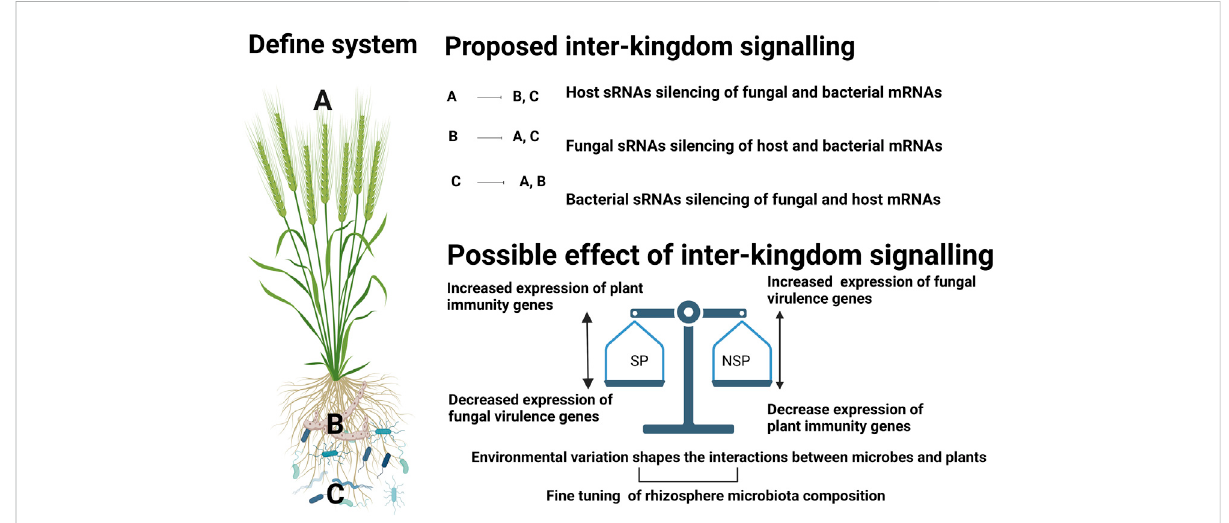
FIGURE 2 Schematic for possible ways of sRNA mediated gene regulation in wheat-rhizoctonia-microbiome interactions and possible effect of such interactions in the context of disease suppressive soils. We proposed involvement of sRNAs from three components: i) plant host, ii). fungal pathogen, iii). bacterial community, with possible multidirectional interactions. During thecomplex interaction of plant association with rhizosphere community, Inter-kingdom signalling might happen in such a way that plant sRNAs (A) could be taken up by fungal (B) (Cai et al., 2018) and bacterial (C) cells thereby mediating regulation of their genes (Teng et al., 2018). In the second case, fungal pathogens can secrete sRNA effectors intohostcellstosuppresshostimmunity(Wangetal.,2017a)andbacterialtranscripts.AlthoughthereisnodirectevidenceoffungalsRNAssilencing bacterial genes, this concept may bear testing in suppressive soils as members of the bacterial community have been identi fi ed as key components that contribute to the suppressive capacity of a soil. In the third case, bacteria can incorporate their sRNAs to modulate host genes (Ren et al., 2019) and also can alter the expression of fungal genes (Chen et al., 2018). The possible effect of this inter-kingdom signalling in suppressive (SP)and non- suppressive(NSP)soilscouldbeasfollows:1.InSP;eitherbacterialorhostsRNAscandecreasetheexpressionofthefungalvirulencegenesresulting inincreased expression ofplantimmunitygenes.InNSP soilsthefungal cell maybefreeto secretesRNA virulence factors that supress expression of plant immunity (such as disease resistance proteins, WRKY transcription factors, s AP2/ERF factors as evident from previous studies (Wang et